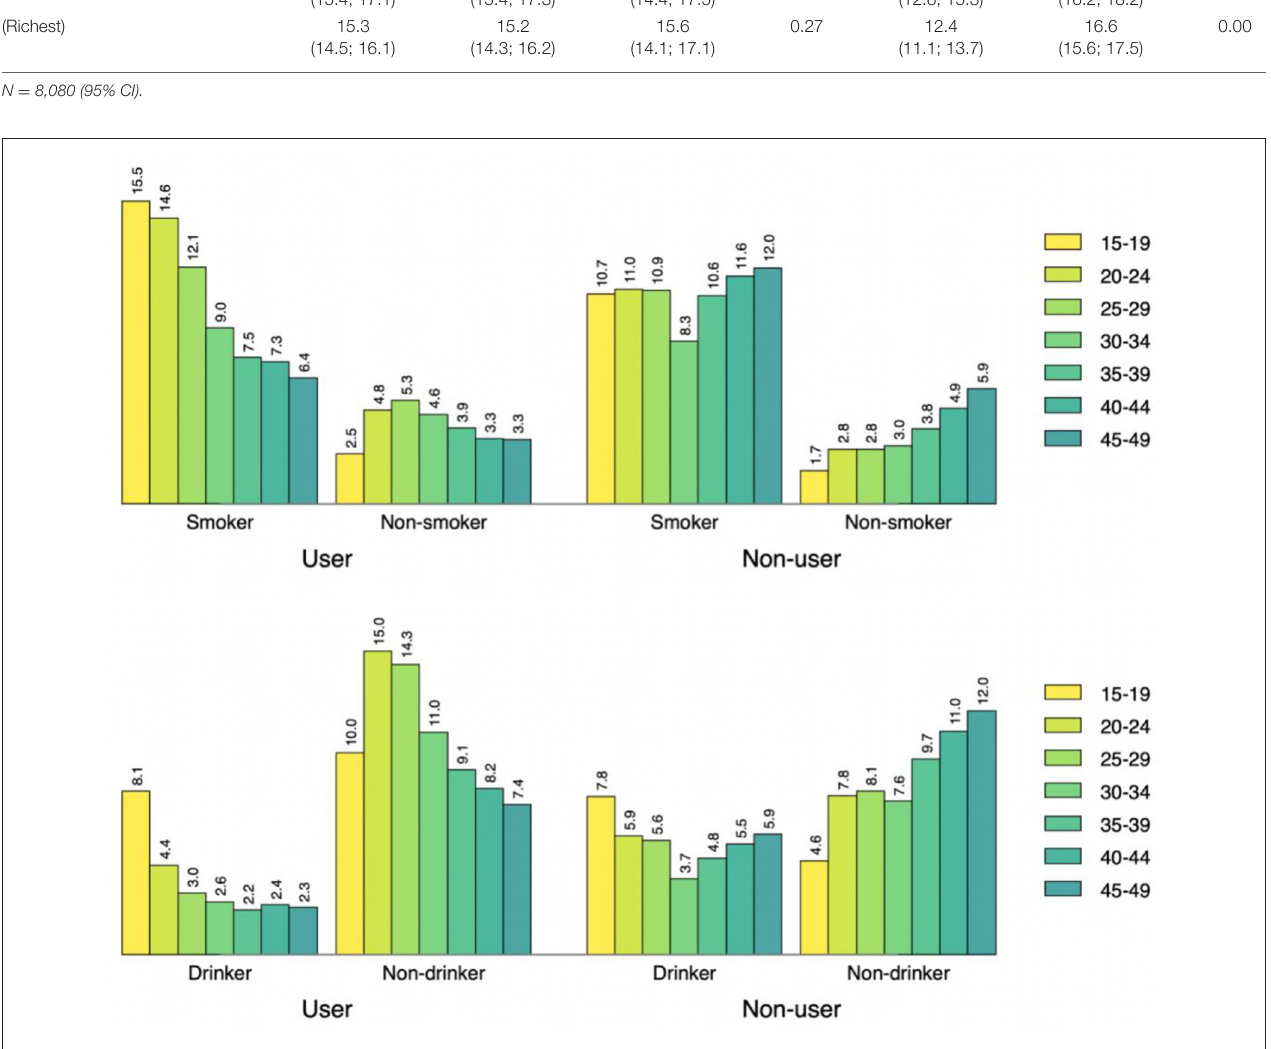
Frontiers in Public Health |